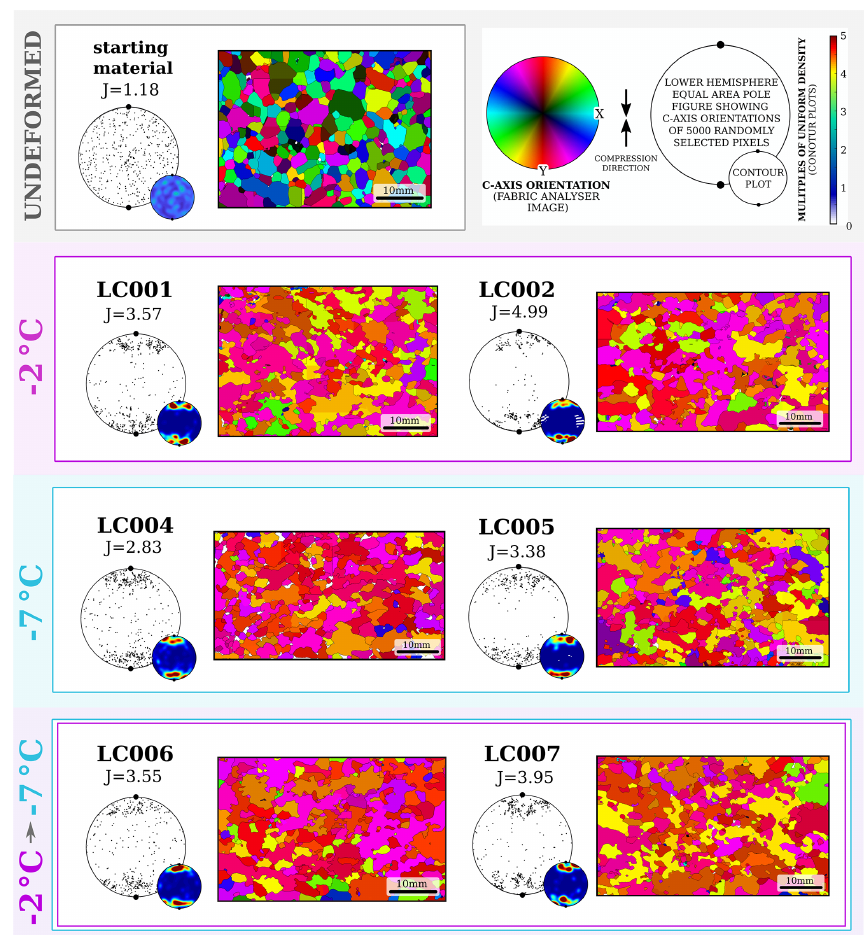
Figure 4. Results from microstructural analysis of all samples in set 1 ( − 2 to − 7 ◦ C), alongside a sample of undeformed standard ice. Shown for each sample, from left to right: sample number and J index above a lower-hemisphere stereonet plot of c -axis orientations of 5000 randomly selected pixels, alongside a contoured plot of the same data (scale shown in the upper right); thin section image from processed fabric analyser data, coloured by c -axis orientations according to the legend (upper